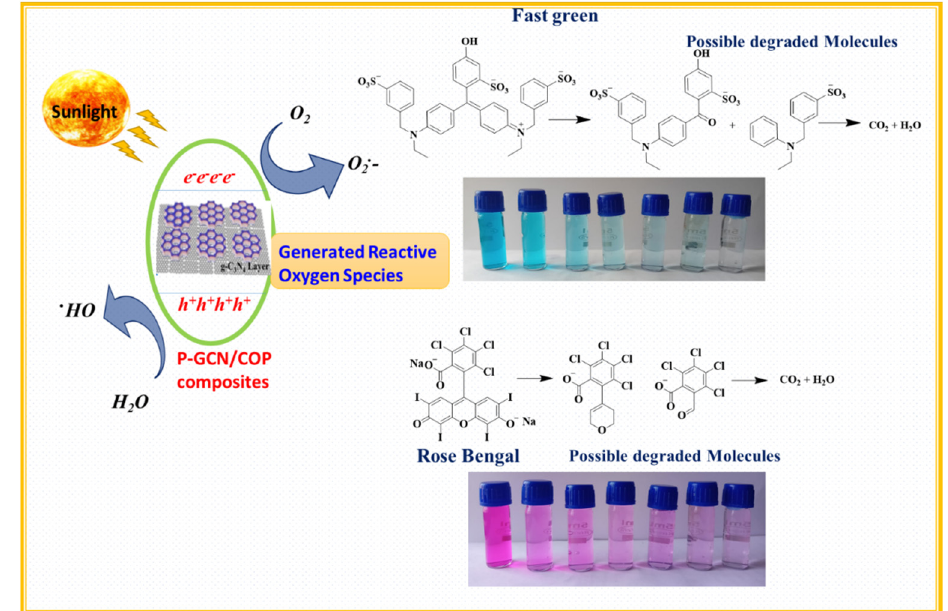
Figure 14. Schematic diagram mechanism of photocatalytic dye